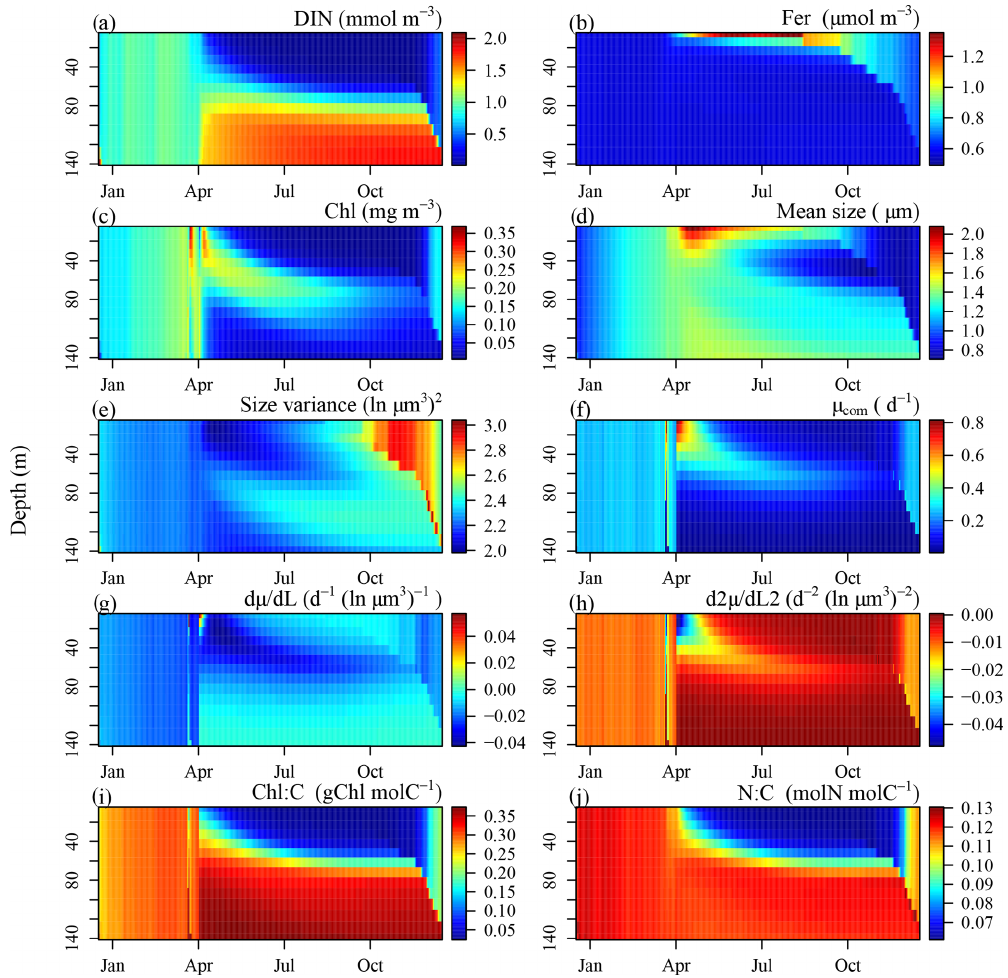
Figure 11. The same as Fig. 10, but for station